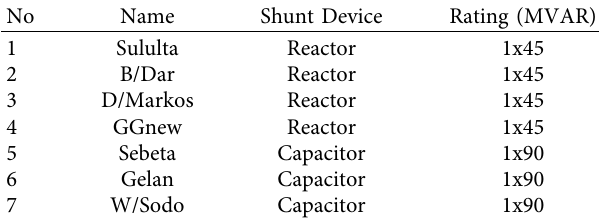
Table 4: Parameters of reactive power